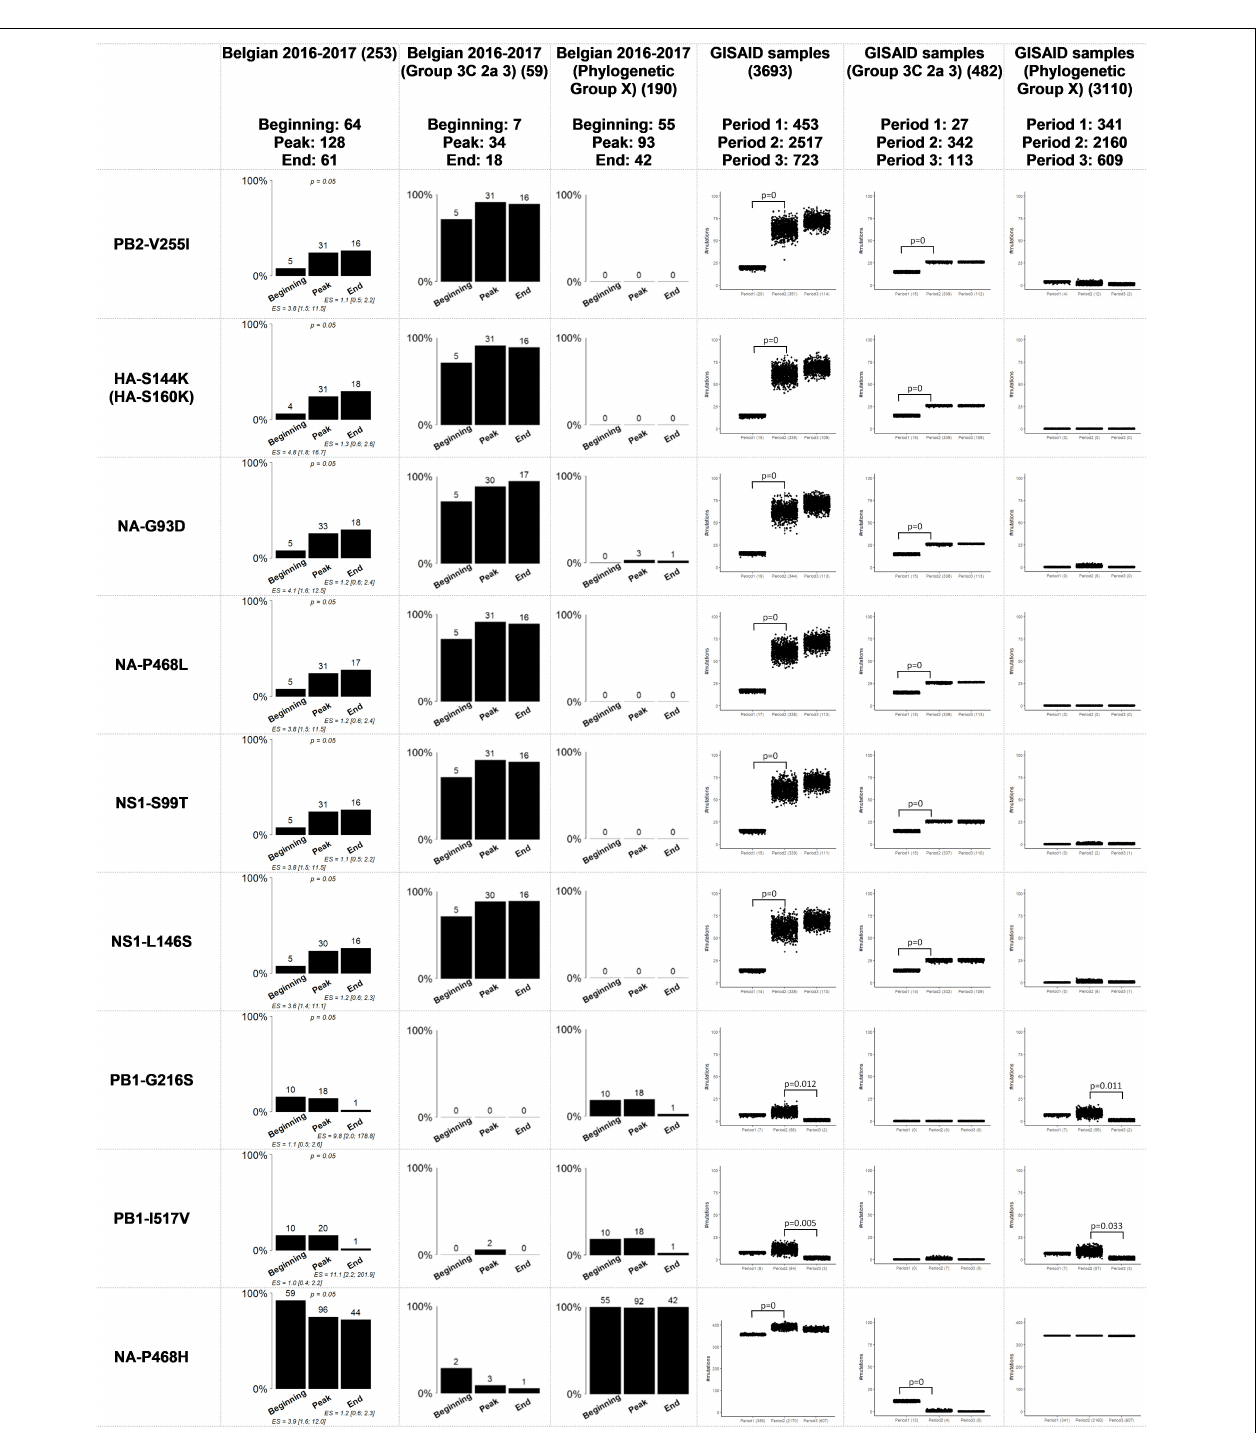
FIGURE 2 | Comparison of the Belgian influenza samples with samples from the GISAID database for mutations that were considered significantly related to the sampling period. The distribution of samples in the groups “Group 3C 2a 3” and “Phylogenetic Group X” is provided for the significant results after running the Fisher’s exact test with FDR correction when the viral genetic background is not taken into account. “Phylogenetic Group X” includes “Group 3C2a1”, “Group 3C2a1(2)”, “Group 3C2a1a”, “Group 3C2a1a (2)”, “Group 3C2a1b”, “Group 3C2a2”, “Group X”, “WGX” and “WGY”. In the graphs representing the situation in Belgium, above the bars the number of samples that had this mutation are indicated. In the graphs representing the samples from GISAID, the number of samples that possessed this mutation are indicated below the chart. The magnitude of the significant association is defined by the effect size (ES) and its confidence interval. The resulting p -value of the Fisher’s exact test with FDR correction for the samples from the Belgian dataset is indicated above bar charts for which significant associations were found. The p -values of the permutation tests performed for the GISAID samples are indicated above the boxplots.